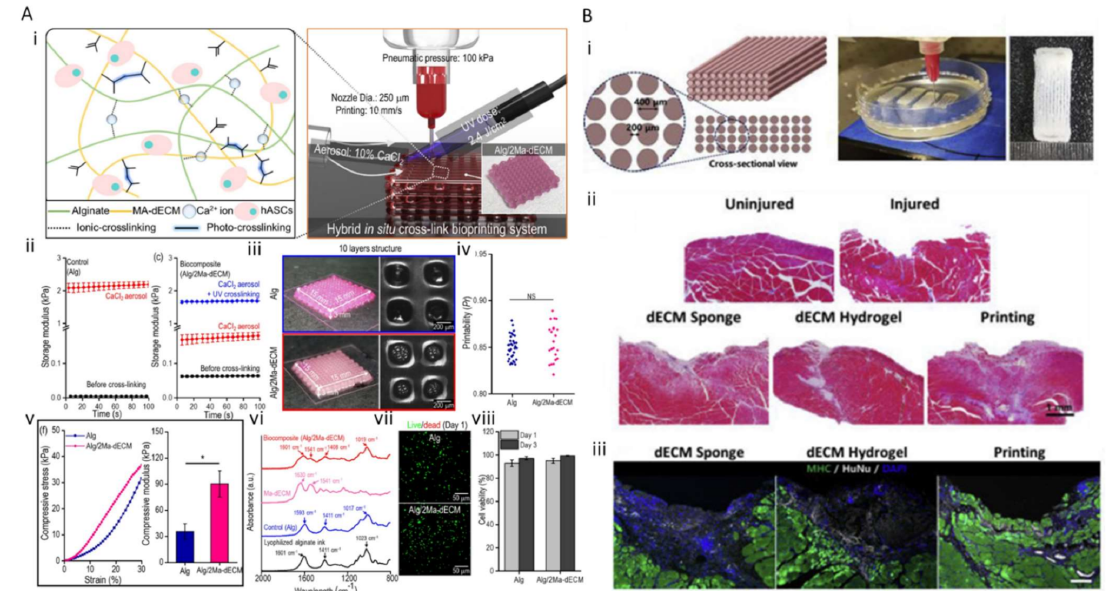
Figure 3. Three-dimensional bioprinting of bone and muscle. ( A ) ( i ) A 3D bioprinted bone construct using Alg/2Ma- dECM; ( ii – vi ) comparison of physical properties including storage modulus, printability, compressive stress, and photo- absorbability in 3D bioprinted bone constructs using alginate and Alg/2Ma-dECM; ( vi – viii ) comparison of biocompatibility of 3D bioprinted bone constructs using alginate and Alg/2Ma-dECM (*, p < 0.05); ( B ) ( i ) 3D-bioprinted skeletal muscle con- struct using mdECM; ( ii , iii ) comparison of regenerative capacity through Masson’s trichrome staining and immunostaining against MHC and HuNu. Reproduced with permission from Refs. [106,115] with slight changes